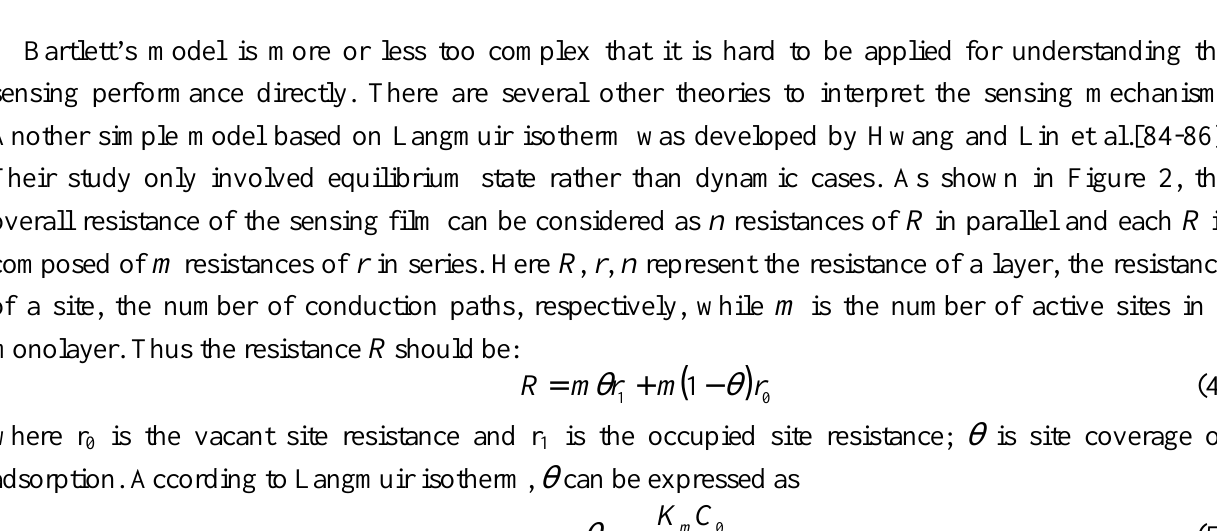
Figure 2. Device configurations and the corresponding equivalent circuit used by Hwang and Lin to investigate adsorption of conducting polymer film in chemresistor type